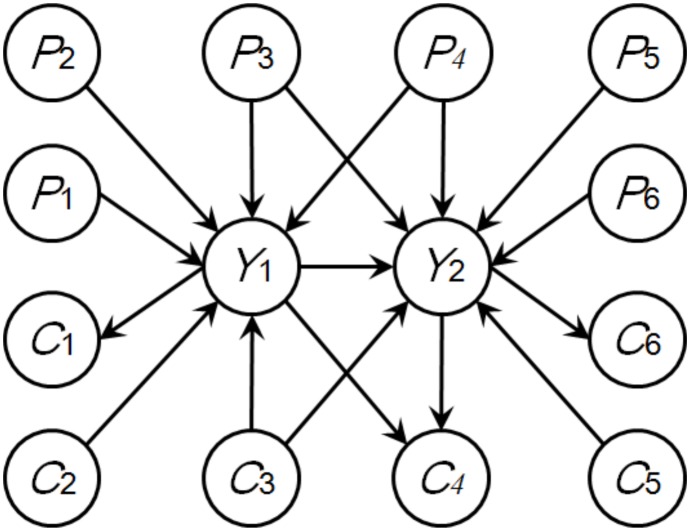
An example of LODG.
Y
1 and Y
2 are two correlated traits; C
2 and C
3 are two traits that have been newly determined as parent nodes of Y
1; Y
1, C
3 and C
5 are three traits newly determined as parent nodes of Y
2; Y
1 is a newly determined parent node of traits C
1 and C
4; Y
2 is a newly determined parent node of traits C
4 and C
6.